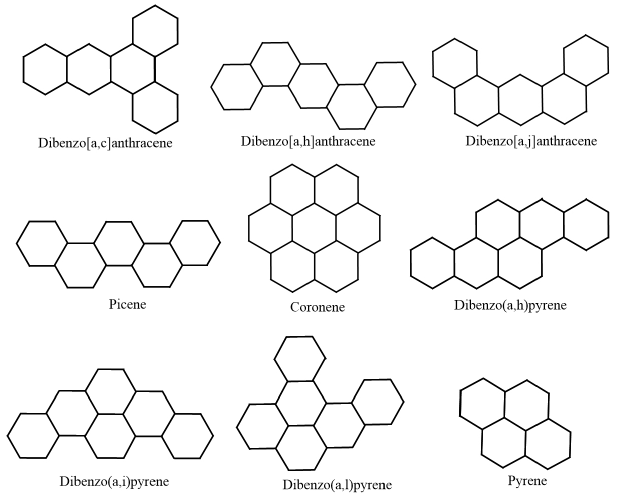
Figure 3. The 22 lower benzenoid